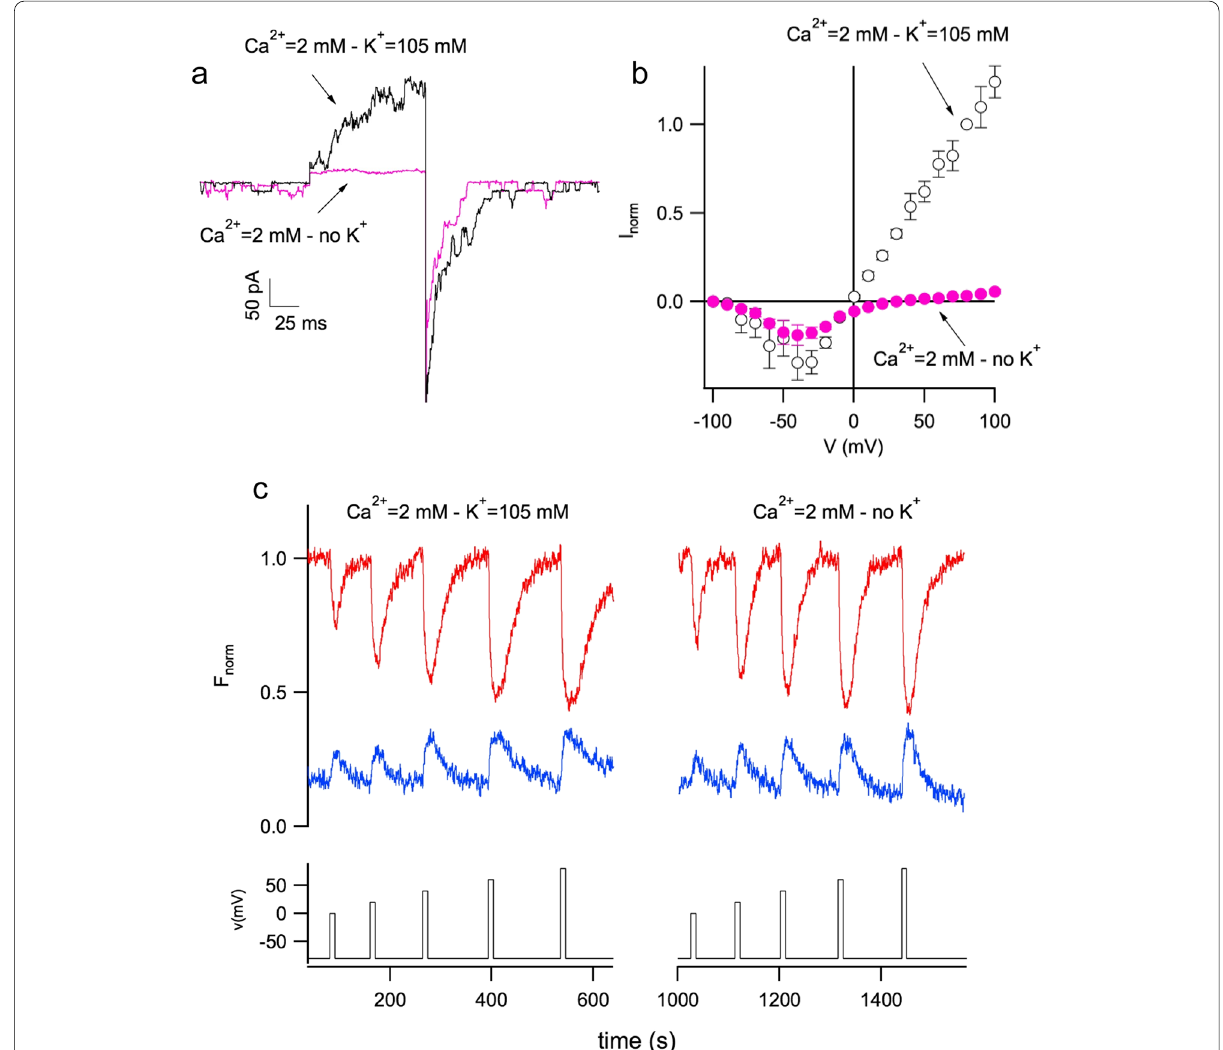
Fig. 4 Removal of cytosolic potassium strongly reduced TPC currents but did not change calcium permeation. a Currents of carrot TPC channels recorded in control condition (Ca 2 + 2 mM – K + 105 mM, black trace) and in the absence of cytosolic K + (Ca 2 + 2 mM – no K + , violet trace). = = = Main voltage pulse of 80 mV lasting 100 ms. Holding and tail voltage of 80 mV. b Stationary currents (normalized to the value at 80 mV in + − + control) in the presence (open black circles) and absence of cytosolic potassium (solid violet circles) were plotted versus applied voltage. c In the upper panel, fura-2 signals did not change significantly in control condition (Ca 2 + 2 mM – K + 105 mM, left panel) and upon removal of cytosolic = = potassium (Ca 2 + 2 mM – no K + , right panel). The lower panel displays the applied voltage (10 s voltage pulses from 0 mV to 80 mV, in 20 mV = + steps, from a holding potential of 80 mV). Modification of Figs. 4 and 5, from Carpaneto and Gradogna (2018), Biophysical Chemistry, 236:1–7, − reprinted by permission from Elsevier (license number